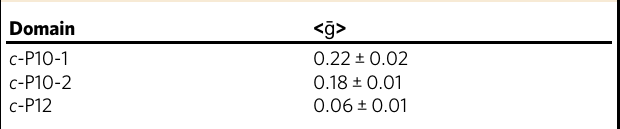
Table 1 Average distortion value, < ḡ >, for nanorings